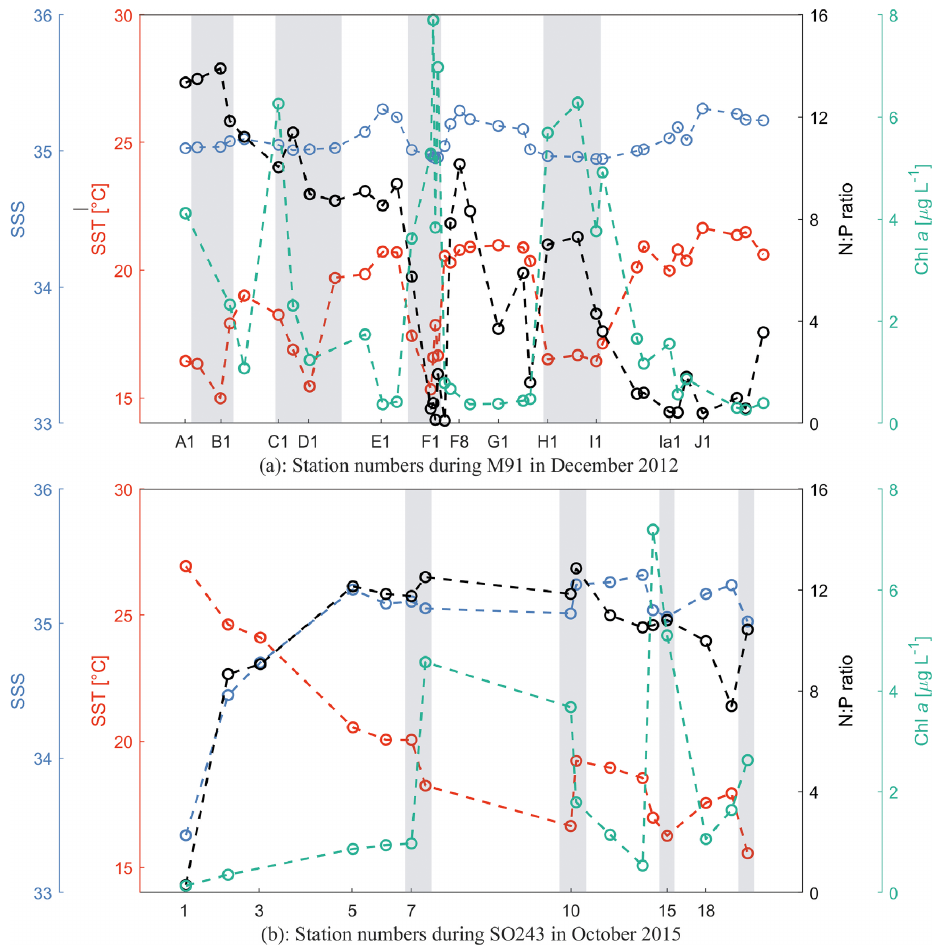
Figure 2. Sea surface temperature (SST; red), sea surface salinity (SSS; blue), N : P ratio (black; N stands for the sum of dissolved nitrate and nitrite, and P stands for phosphate), and chl a (green) at each station during M91 (a) and SO243 (b) . Grey rectangles indicate coastal CTD stations. All values from both cruises are integrated between